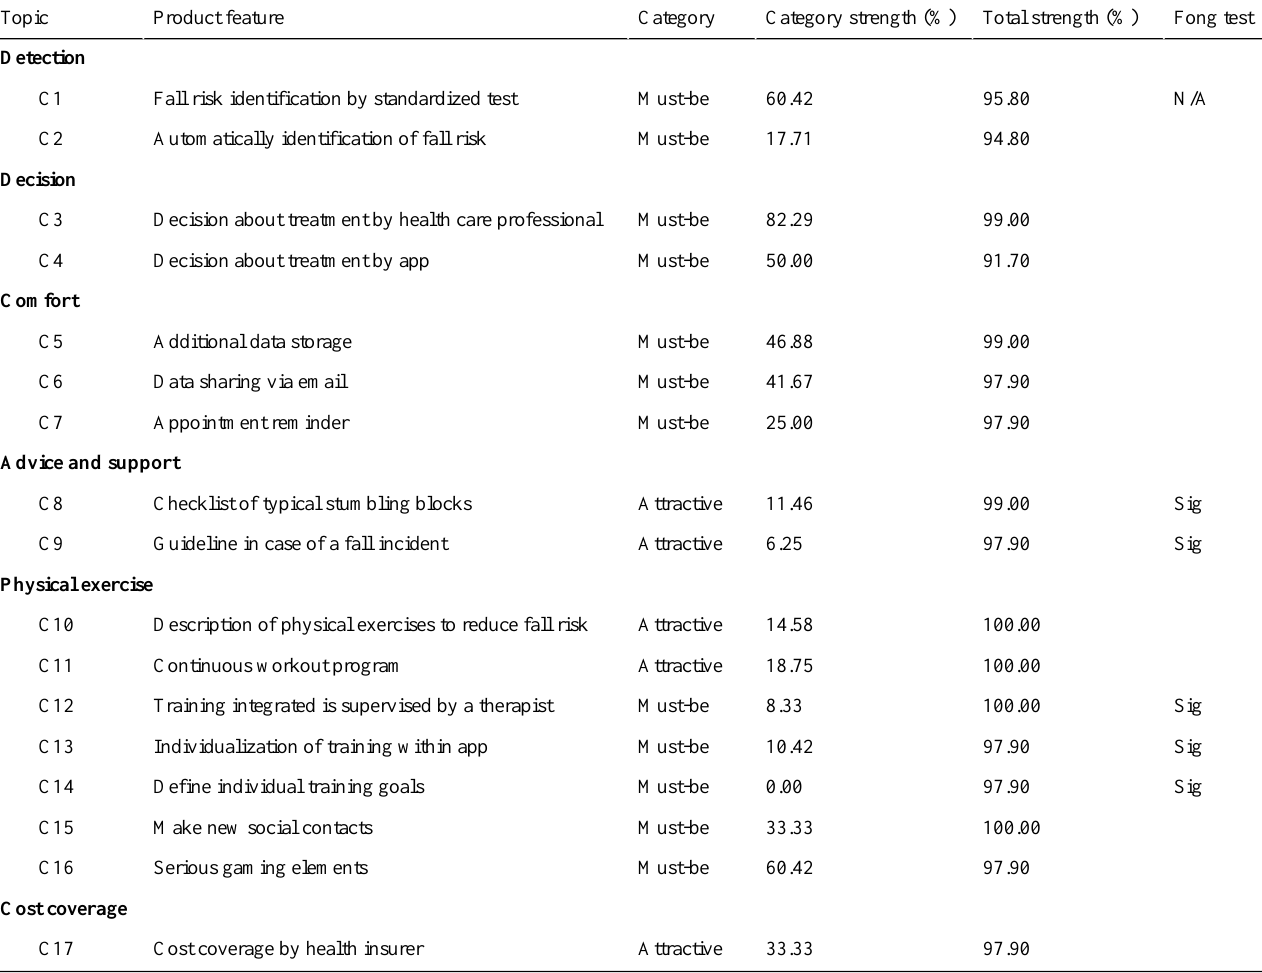
Table 2. Investigates functions of a fall prevention app and their results. C: criteria. N/A: not applicable. Sig: significant categorization according to Fong